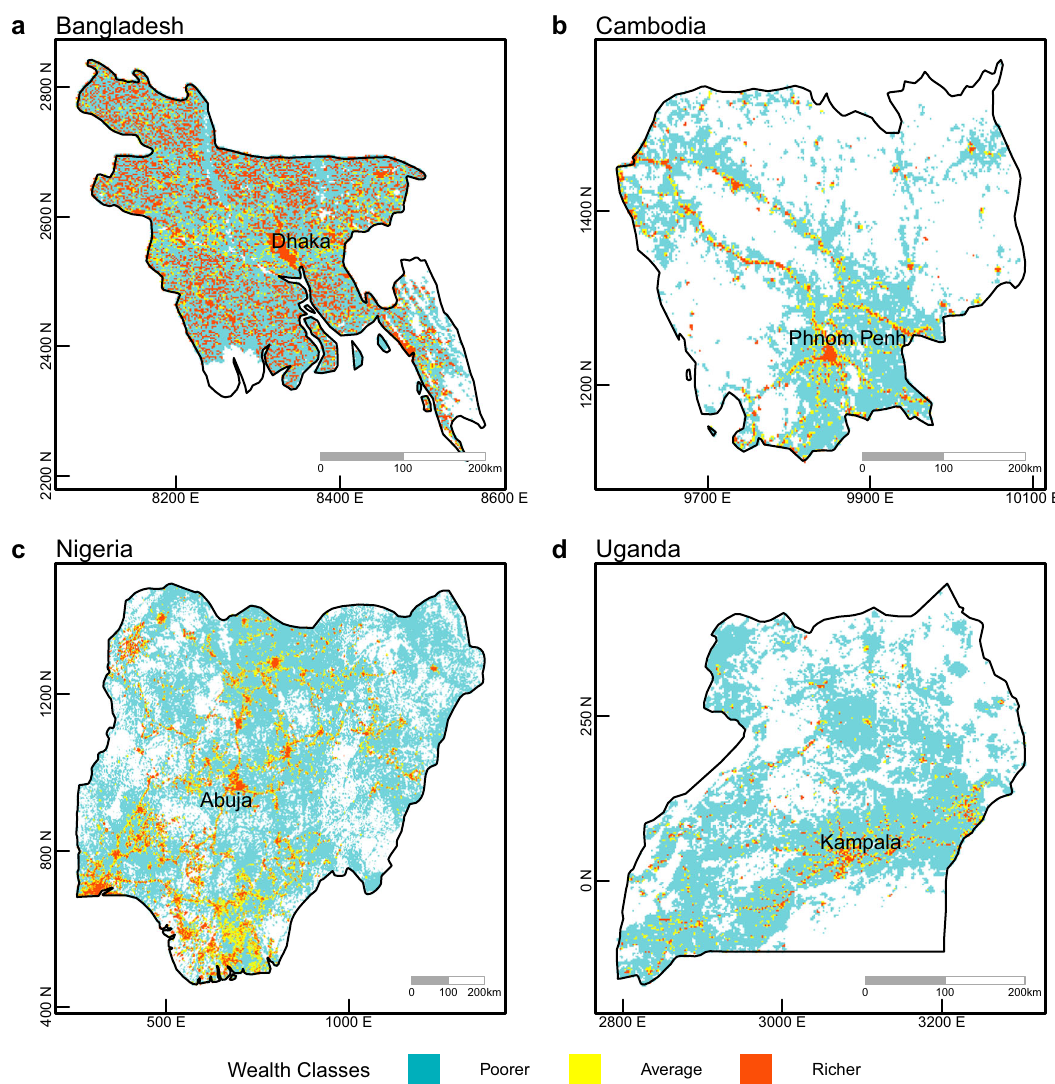
Fig. 3 Country-level maps based on out-of-sample predictions showing the estimated relative wealth class (Poorer, Average or Richer) within a 2.5 km pixel. a Bangladesh. b Cambodia, c Nigeria. d ; Uganda. Capital cities are shown. Map coordinates in kilometers north and east.